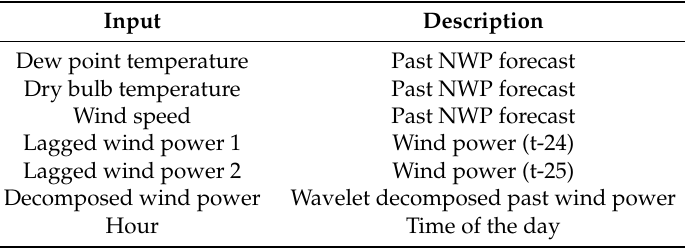
Table 2. Inputs to the forecast